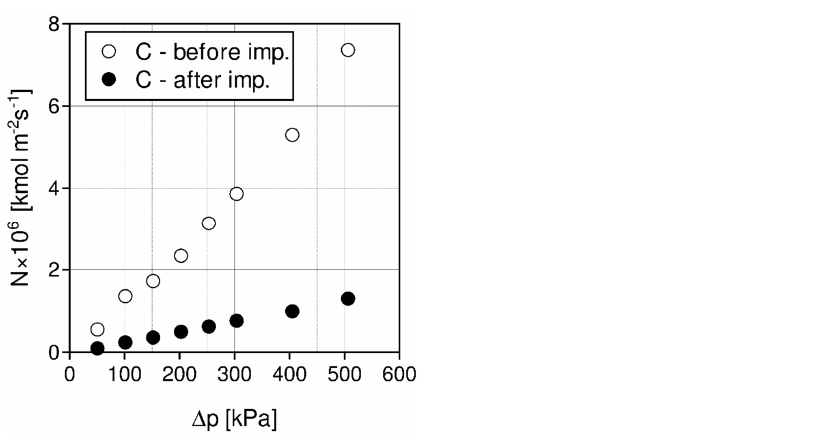
Figure 7. Ideal CO 2 /N 2 selectivity for SILMs based on membranes A, B and C impregnated with [Emim][Ac], temperature 20 °C.